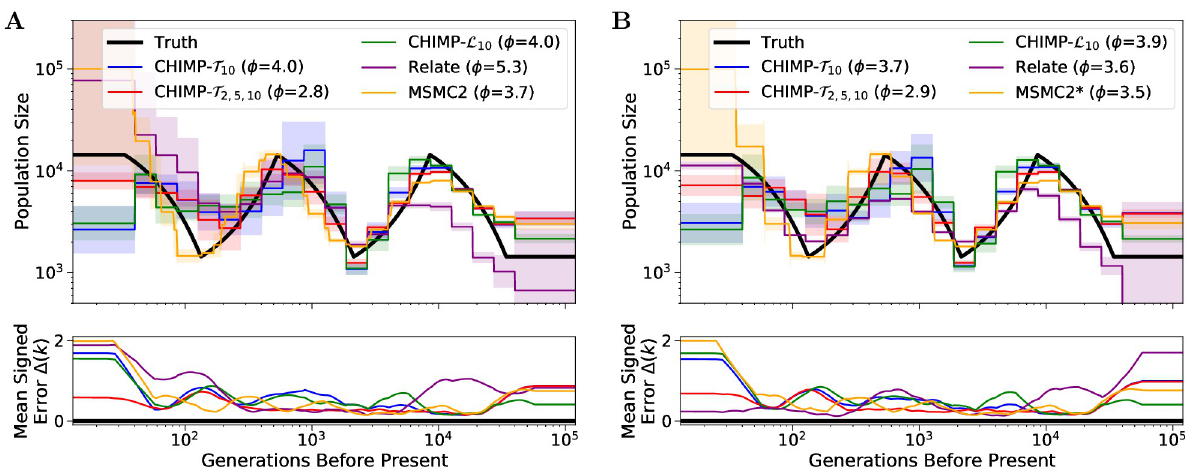
Fig 8. Results of inference in the continuous sawtooth scenario for sample size 10 (Panel A) and 200 (Panel B). We compare the results of CHIMP , MSMC2 , and Relate using a piecewise constant population size history with 19 change points. Truth shown in black. Solid lines are averages over 16 replicates and shaded areas indicate standard deviation. Mean signed error Δ ( k ) is shown at bottom and has been smoothed using moving average for visualization purposes. The integral ϕ is indicated in the legend. ( � ) For sample size 200, MSMC2 was run on 50 non-overlapping pairs.